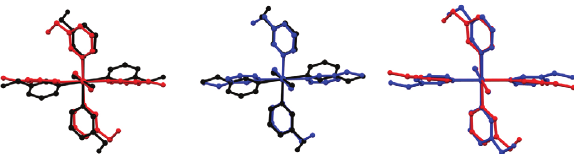
(3PM) molecules in 1 2 4 (3PM) molecu- 2 4 (3PM) 2 4